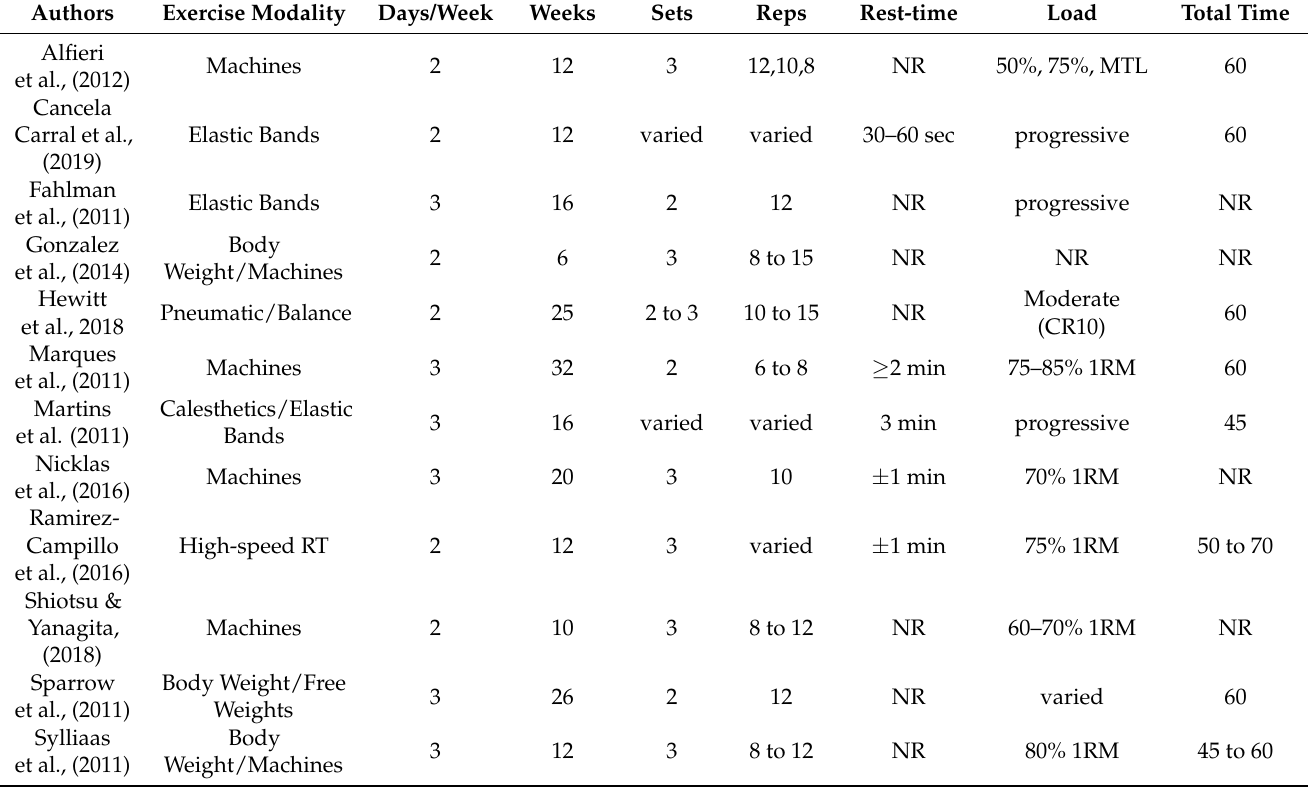
Table 3. Resistance training intervention